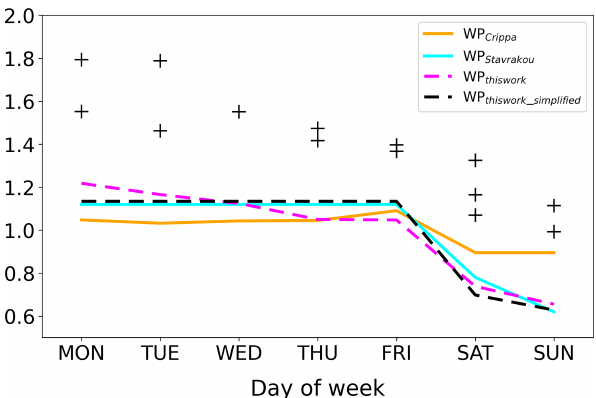
Figure 17. Normalized weekly profiles (WPs) of NO x emissions over the Antwerp area that are (1) based on Crippa et al. (2020; or- ange line), (2) adopted by Stavrakou et al. (2020; blue line), and (3) derived in this work (dashed magenta line), based on the opti- mization of daily emissions constrained by in situ NO 2 data. Also shown is the simplified weekly profile adopted in further model calculations (see the text). The crosses represent the daily emis- sion scaling factors needed to match the in situ data in the model. The dashed magenta line is the normalized temporal variation in emissions needed to match NO 2 data (obtained by multiplying the daily averaged scaling factors by the weekly profile from Crippa et al., 2020, followed by